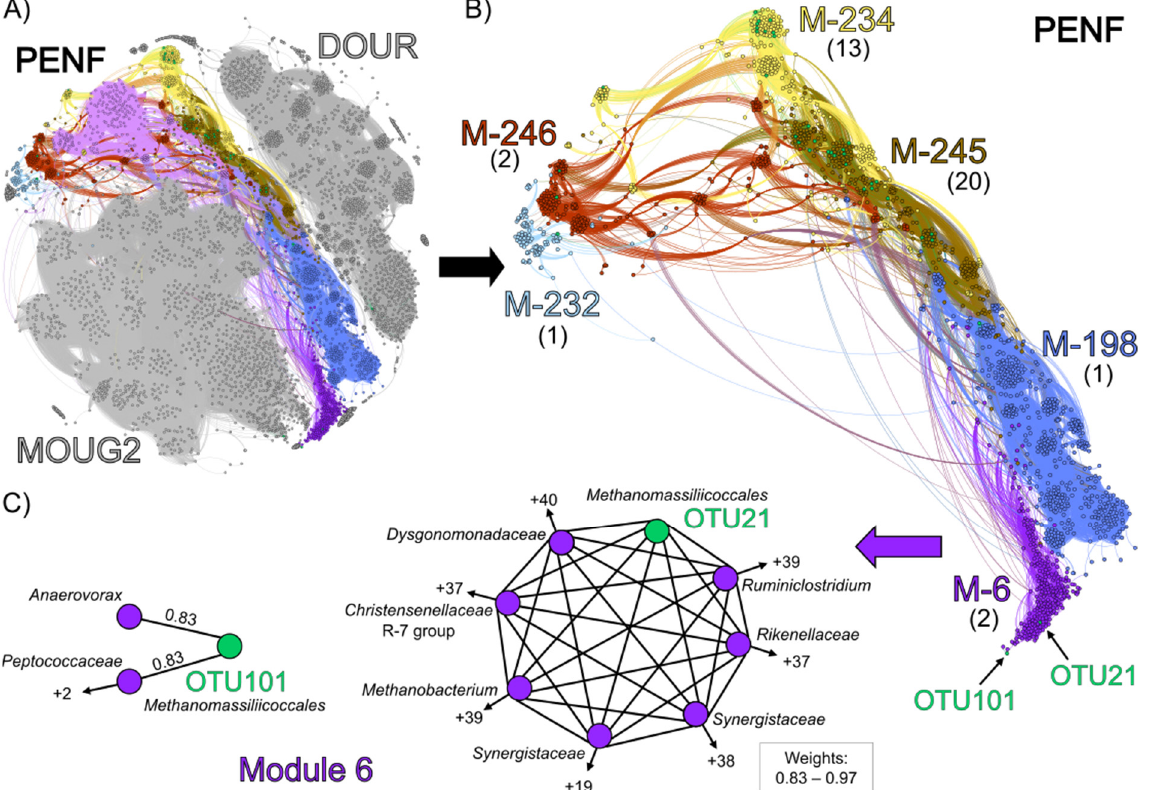
Figure 6. Co-occurrence network reconstructed based on 16S rRNA gene-sequencing data from substrate-amended slurries (DOUR, PENF, and MOUG2, respectively), based on a Spearman rank’s correlation between OTUs and calculated with a percolation threshold of 0.79. ( A ) Clusters in slurries DOUR, PENF, and MOUG2, respectively. Modules in PENF network are colored to highlight them; ( B ) modules (M-6, module 6; M-198, module 198; M-232, module 232; M-234, module 234 and M-245, module 245, respectively) containing Methanomassiliicoccales in the cluster from the PENF culture-based incubation experiment. Modules consisting of a single Methanomassiliicoccales (modules 22 and 68, respectively) were excluded. The number of Methanomassiliicoccales in each module is shown in brackets; ( C ) non-random co-occurrences between Methanomassiliicoccales and other prokaryotes in module 6 showing co-occurrences of Methanomassiliicoccales (OTU21 and OTU101, respectively) with putative acetate- and H 2 -producing bacteria. Black arrows followed by a plus and a number indicate the number of taxa non-randomly co-occurring with other prokaryotes outside the groups represented. The weights of the co-occurrences are written above the link (OTU101) or in the insert below the cluster of the OTU21.